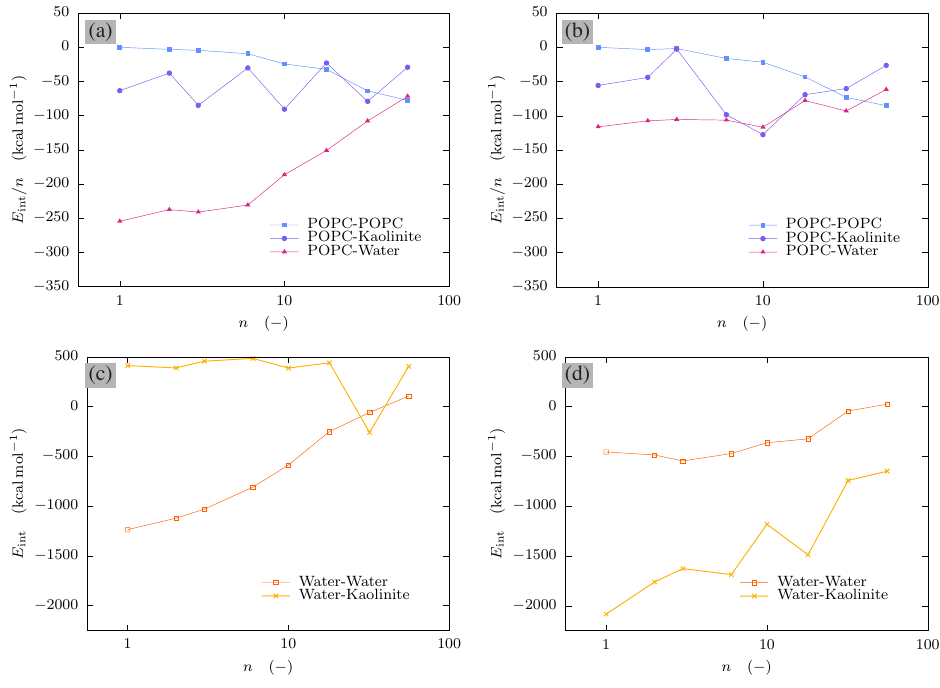
Figure 6. Interaction energies of various pair moieties with respect to their surface loading n for hydrophobic siloxane ( a , c ) and hydrophilic alumina ( b , d ) kaolinite surface. Displayed pair moieties correspond to POPC–POPC (ultramarine squares), POPC–kaolinite (indigo, circles), POPC–residual water (magenta triangles), residual water–residual water (orange empty squares) and residual water– kaolinite (gold crosses),